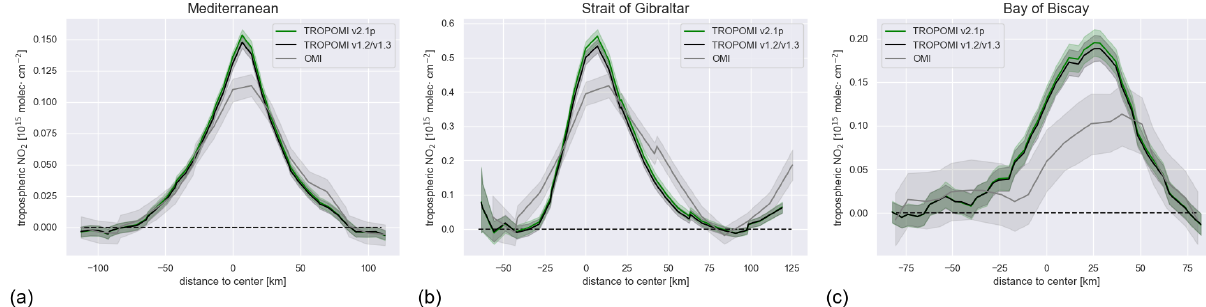
Figure 9. Mean enhancement cross sections in June–August 2019. TROPOMI v1.2–v1.3 in black, the improved TROPOMI v2.1p in green, and OMI in grey. Shaded areas indicate the 95% confidence